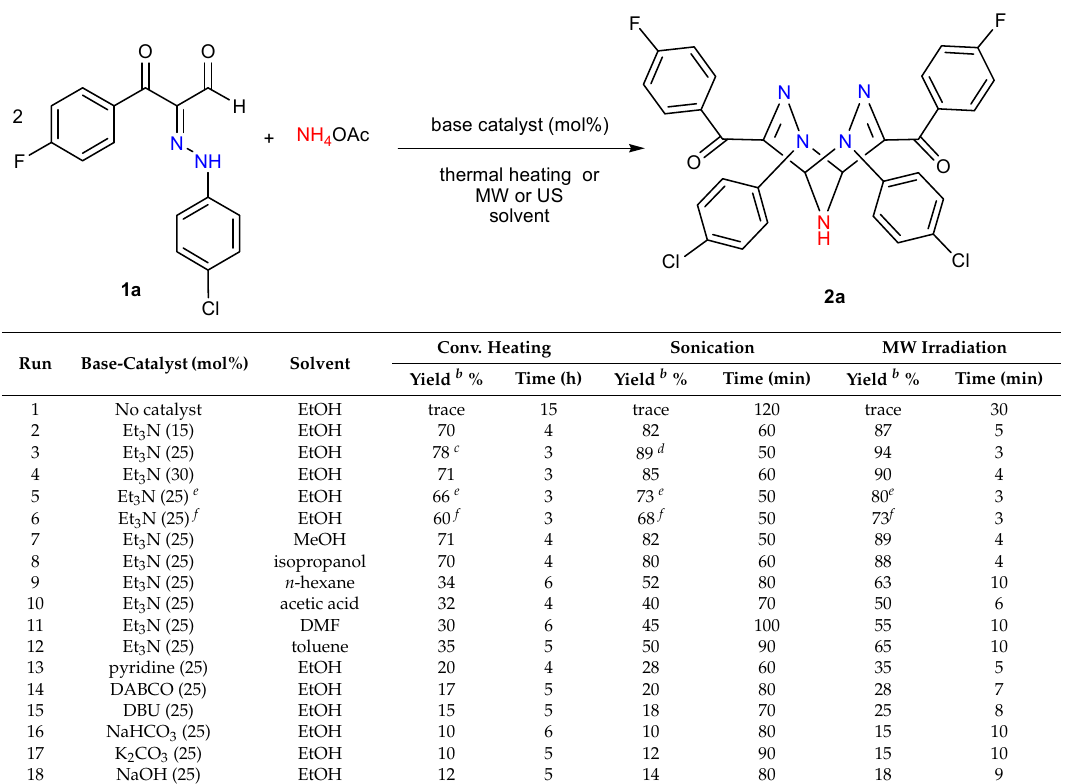
Table 1. Optimization the dimerization condition of 3-oxo-2-arylhydrazonopropanals 1a with ammonium acetate a.